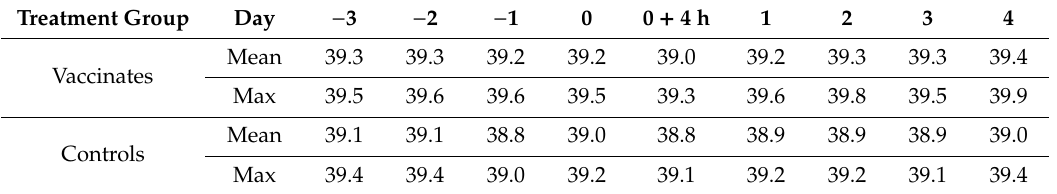
Table 3. Average body temperature ( ◦ C) in the first term of pregnancy in rabbits per day. Treatment Group